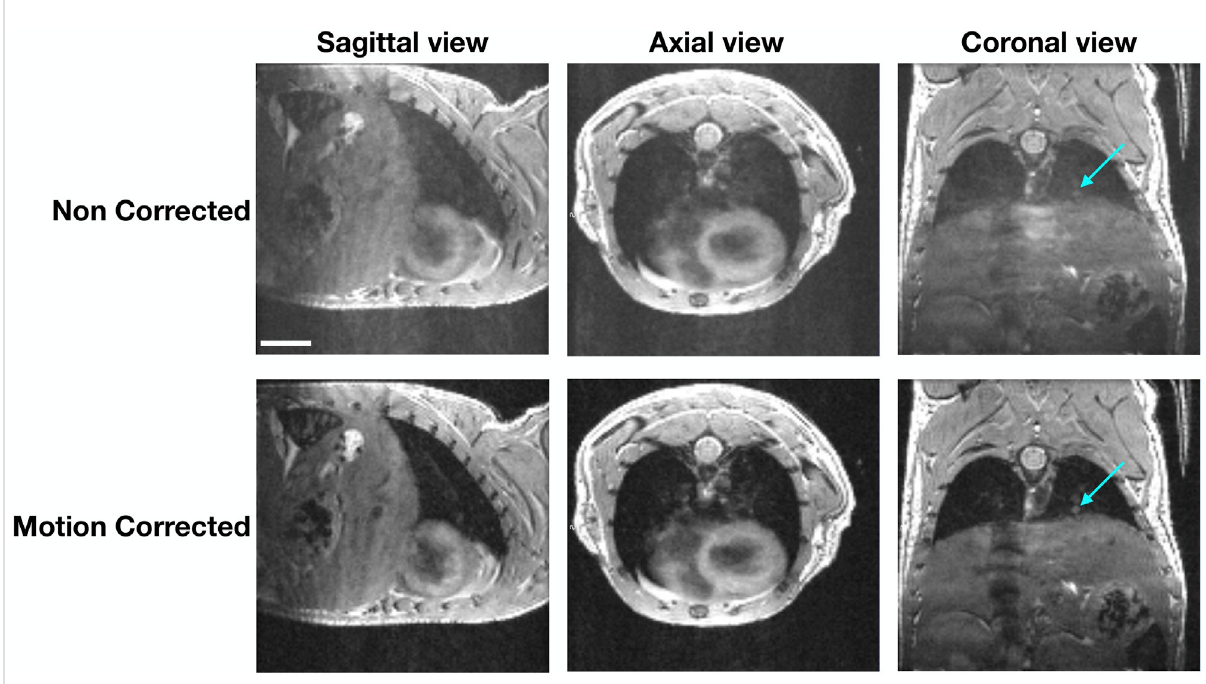
FIGURE 3 Differences between 3D bSSFP images in the 3-axis spatial direction. Images of a representative mouse before and after motion correction are shown. The arrows point to a pulmonary lesion that can be better depicted on the motion-corrected images. The scale represents 4.5 mm .